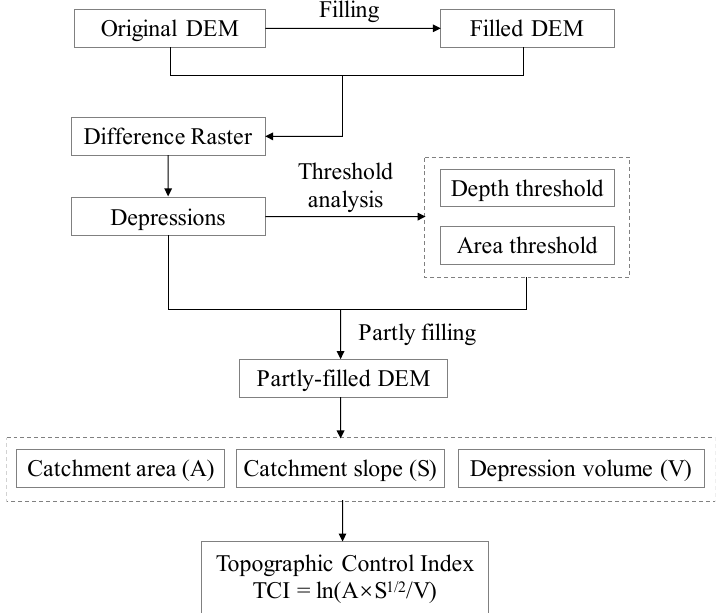
Figure 2. The workflow to derive the Topographic Control Index for depressions.